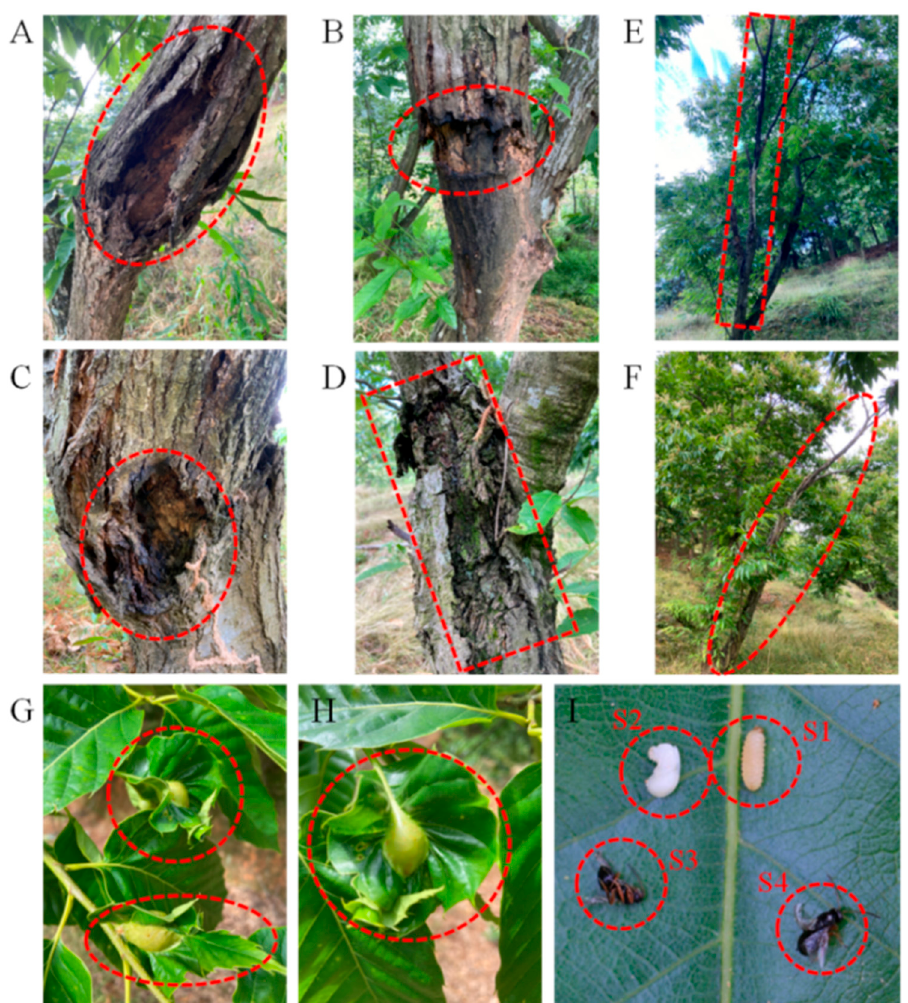
Figure 2. Main diseases and pests of chestnut. Characteristics of chestnut stem after Cryphonectria parasitica infection ( A – F ). The bark and phloem of chestnut trees can be severely damaged by Cryphonectria parasitica ; however, the xylem can remain fully intact and functional, and the trees can remain alive ( A – D ). However, the xylem can be severely damaged after infection, and the trees can die ( E , F ). Leaf galls induced by Dryocosmus kuriphilus on a chestnut tree ( G , H ); larvae ( I ‐ S1,S2) and adults ( I ‐ S3,S4) of Dryocosmus kuriphilus. Three different development forms of Dryocosmus kuriphi ‐ lus appear simultaneously on the same chestnut tree in May. The photos were taken in a private orchard in Qingyuan County, Lishui City, Zhejaing Province,